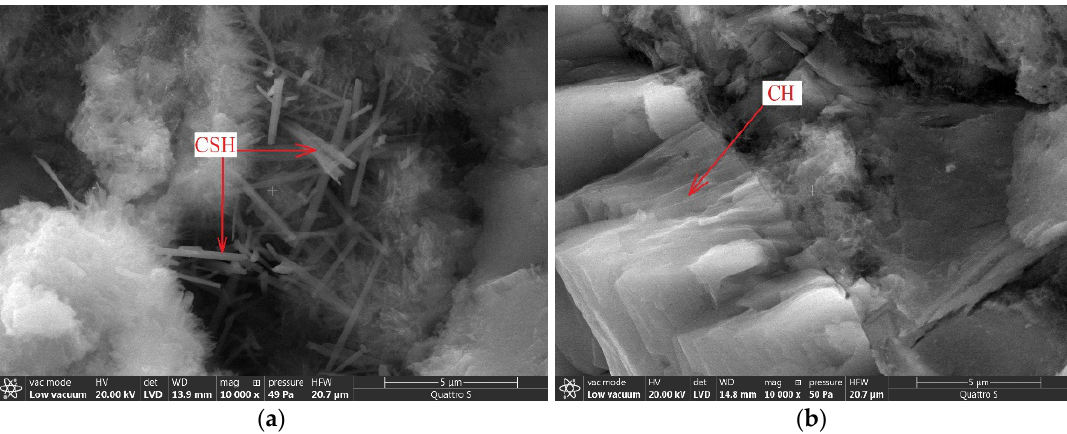
Figure 7. Morphological features of hydration products at 10,000-fold magnification: ( a ) sample with 7% of carbon nanotubes ( b ) sample with 7% of carbon nanotubes and 3% of calcium nitrate.